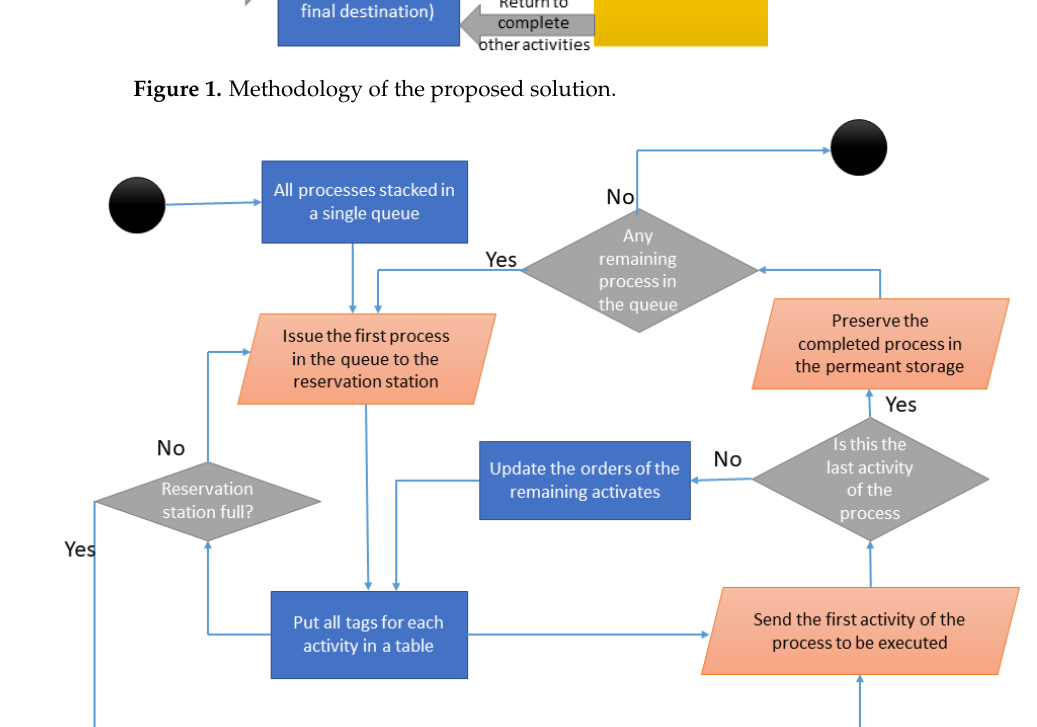
Figure 2. Flow chart of the proposed